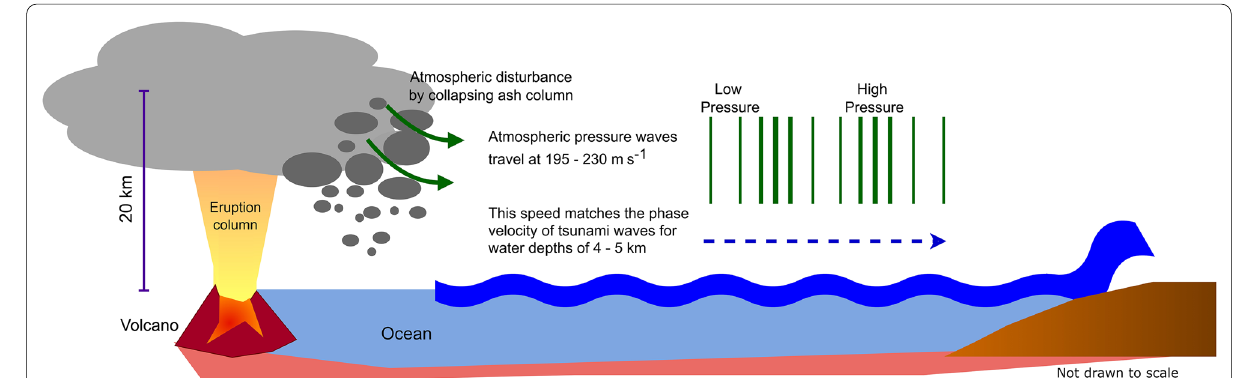
Fig. 5 Generation of volcanic-meteotsunamis (VMTs). Collapsing eruption column produces atmospheric pressure waves. If the lateral speed of the atmospheric waves matches the tsunami waves, water resonance occurs, amplifying the VMTs. Adapted from original by Lowe and De Lange